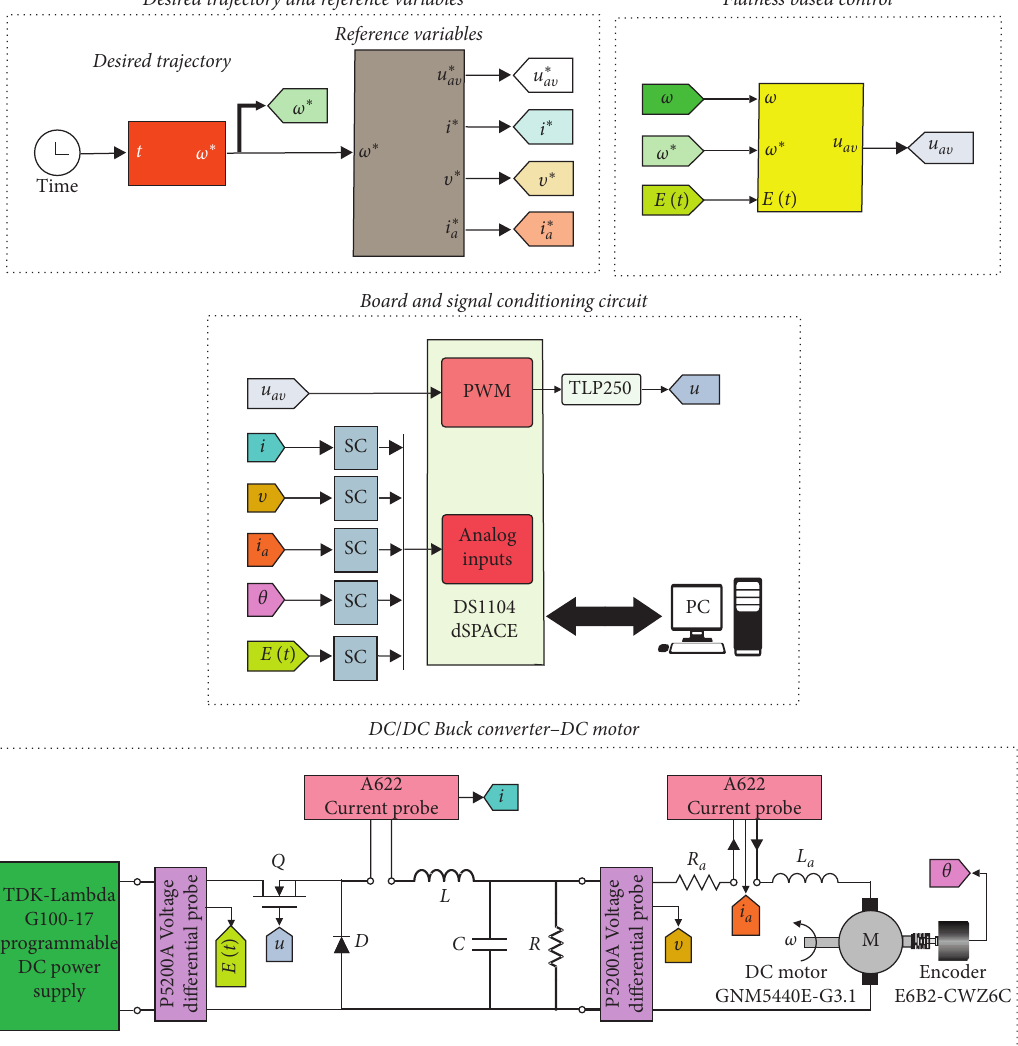
Figure 9: Diagram of the experimental testbed associated with the DC/DC Buck converter-DC motor